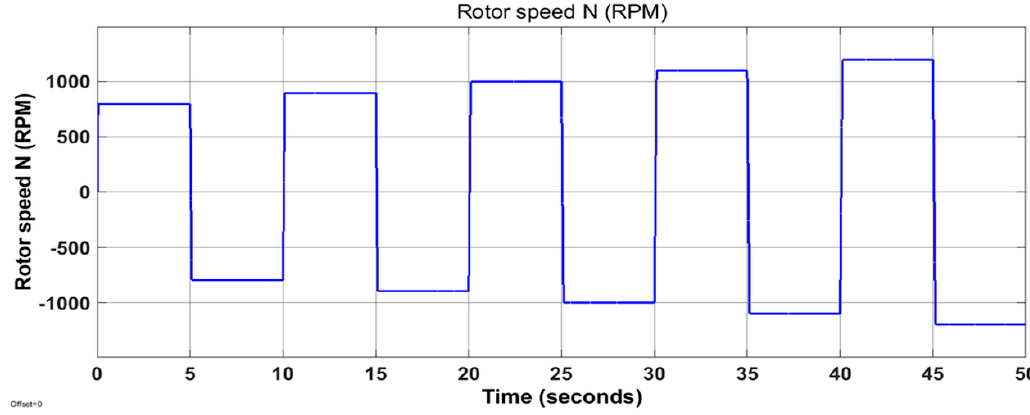
Figure 5. Speed over a period of 50 s.